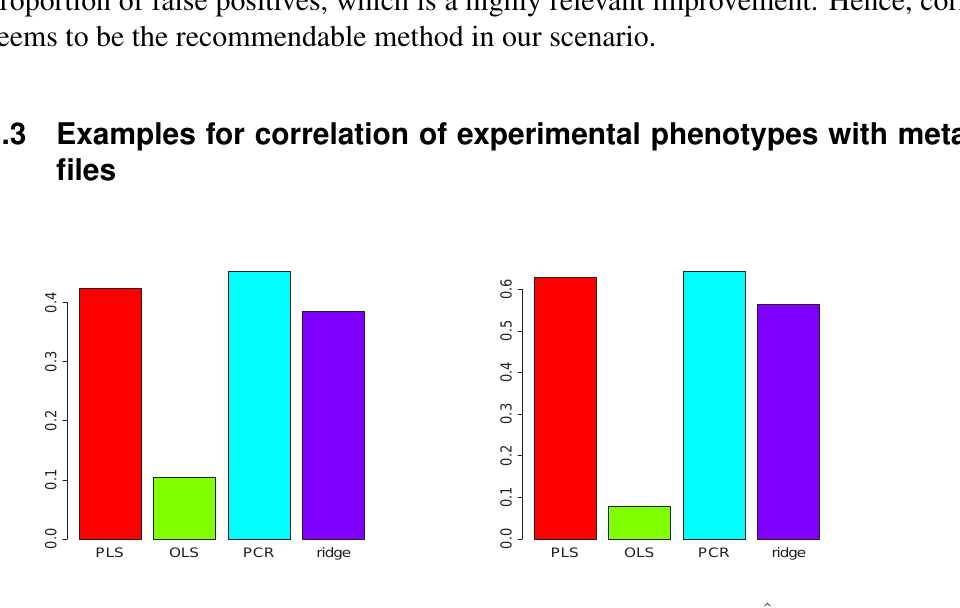
Figure 6: Comparisons of cross-validation correlations of predicted ˆ Y and the true Y for the four methods in question, for two phenotypical traits of the tomato dataset. Left: fruit length, right: harvest index. OLS performs worst in both cases, the three alternative methods show higher correlations of predicted and true